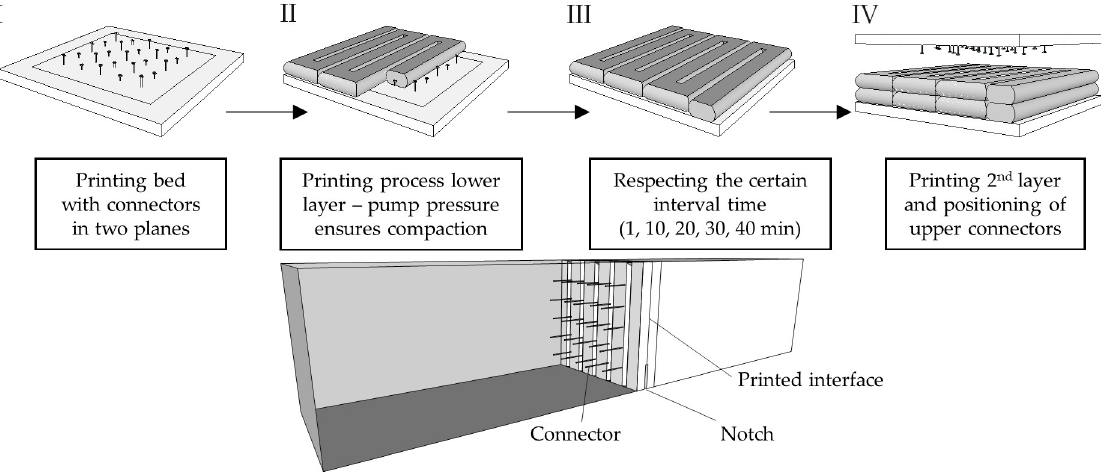
Figure 5. Schematic depiction of production of hybrid specimens with 150 mm edge length and nail connection to self-compacting concrete.